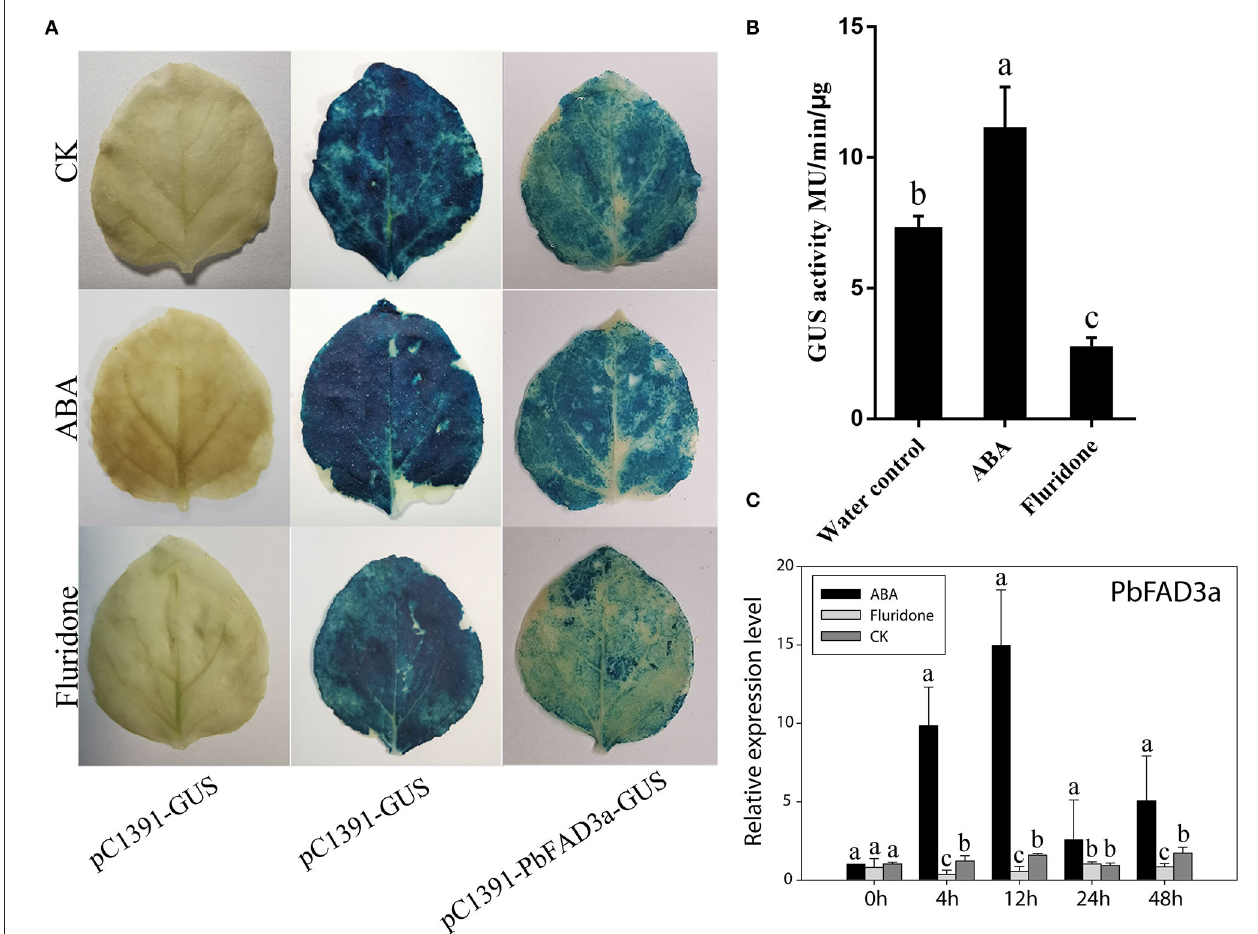
FIGURE 10 | PbFAD3a involved in russet pear skin formation in response to ABA. GUS staining (A) and GUS activity (B) in transient Nicotiana benthamiana leaves after treatments of pure water, ABA and fluridone. (C) The expression pattern of PbFAD3a after ABA and fluridone treatments in pear calli. The error bars are the means ± SD of three biological repeats and lowercase letters indicate significant differences by two-tailed Student’s t -test ( p <